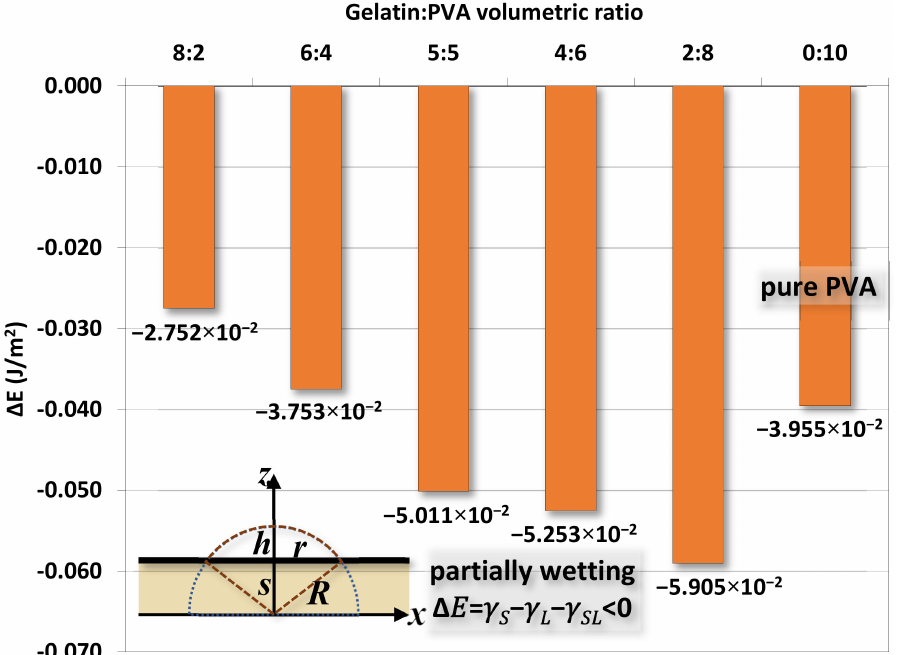
Figure 16. The optimal estimate of interfacial energy ∆ E from the width r of water contact and model proposed by Härth and